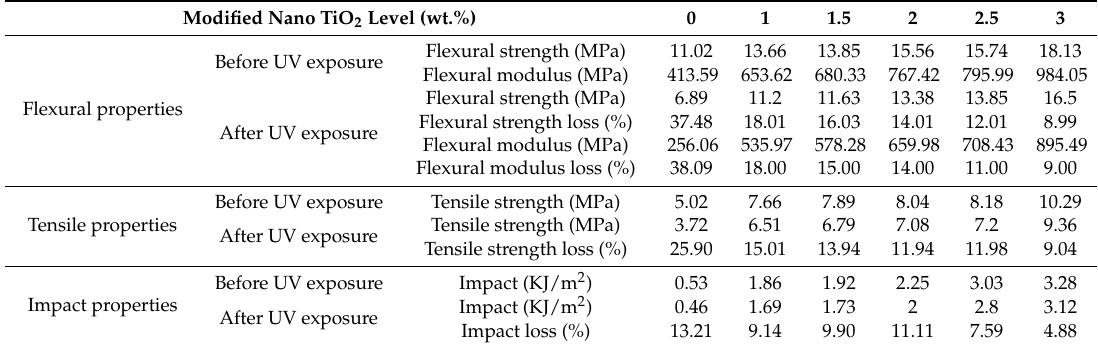
Table 2. The change and reduction ratio in mechanical properties of wheat straw fiber/PP composites with different modified TiO 2 nanoparticle content after UV